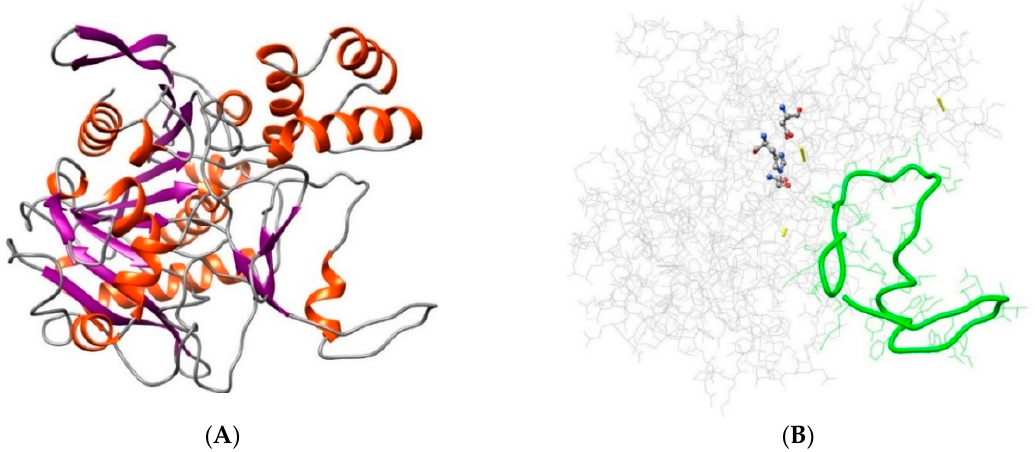
Figure 1. Depiction of the best 3D model for the Nf 314 proenzyme. ( A ) Ribbon representation, colored according to the secondary structure: α -helix in red and β -sheet in purple. ( B ) Wire representation, colored in gray, with the specific location of important features (particularly highlighted): the three predicted disulfide bonds (yellow sticks), the catalytic triad (balls/sticks colored by the element), and the putative non-terminal propeptide region (tubular/wire in green).